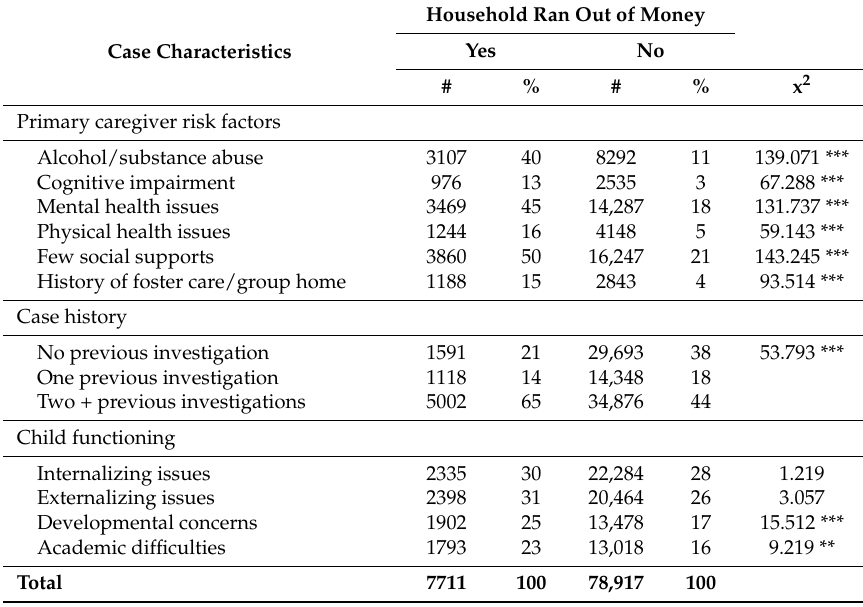
Table 3. Bivariate analyses for all maltreatment-related